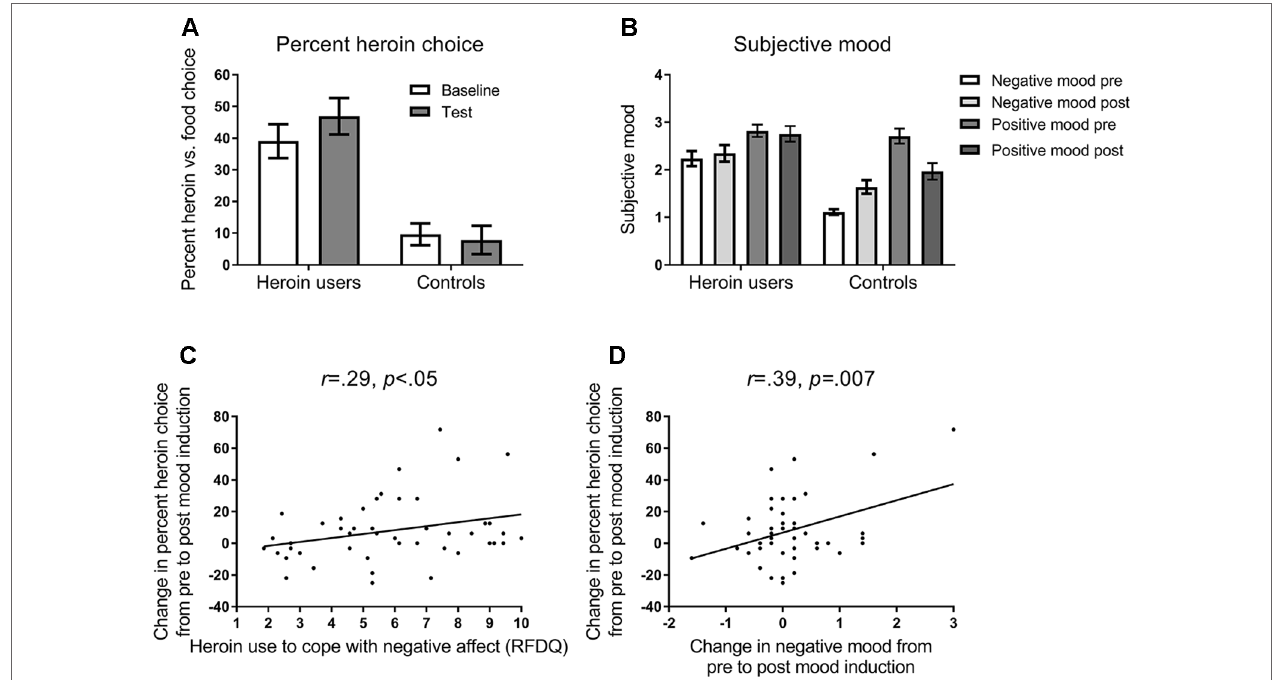
FIGURE 2 | (A) Mean percent (and SEM) choice of heroin versus food pictures in the baseline and test blocks of the task (see Figure 1 ). Opiate-dependent participants showed a higher rate of heroin choice overall compared to control participants, and showed a mood induced increase in heroin choice at test, whereas controls did not. (B) Subjective negative and positive mood states reported at pre-induction and post-test timepoints (see Figure 1 ). Opiate-dependent participants showed no overall change in subjective mood states, whereas control participants showed an increase in negative mood and a decrease in positive mood following mood induction. (C) Scatterplot and regression slope relating the mood-induced change in percent heroin choice to self-reported opiate use to cope with negative affect in opiate-dependent participants. (D) Scatterplot and regression slope relating the mood-induced change in percent heroin choice to self-reported change in negative mood in opiate-dependent